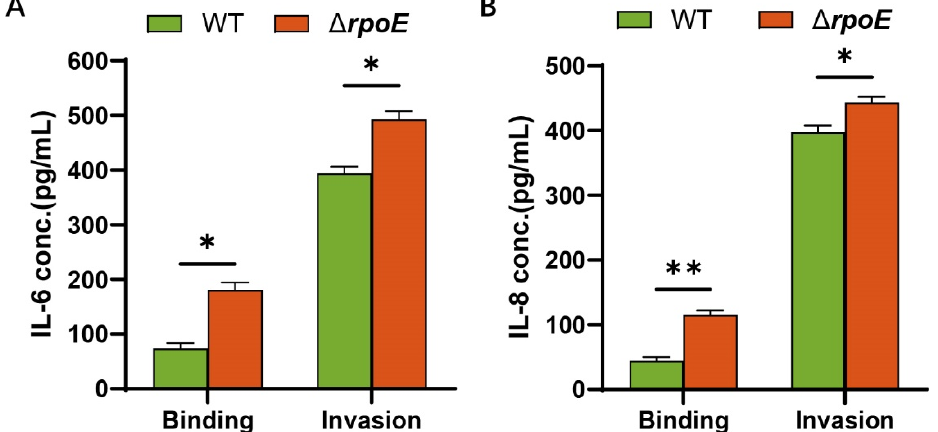
Figure 7. Cytokine release by HBMECs incubated with E. coli K1. ( A ) The levels of IL-6 in the culture supernatants of HBMECs that infected WT and Δ rpoE . ( B ) The levels of IL-8 in the culture supernatants of HBMECs that infected WT and Δ rpoE . Data were obtained from three independent experiments and analyzed using Student’s t -test. * p < 0.05, ** p < 0.01.